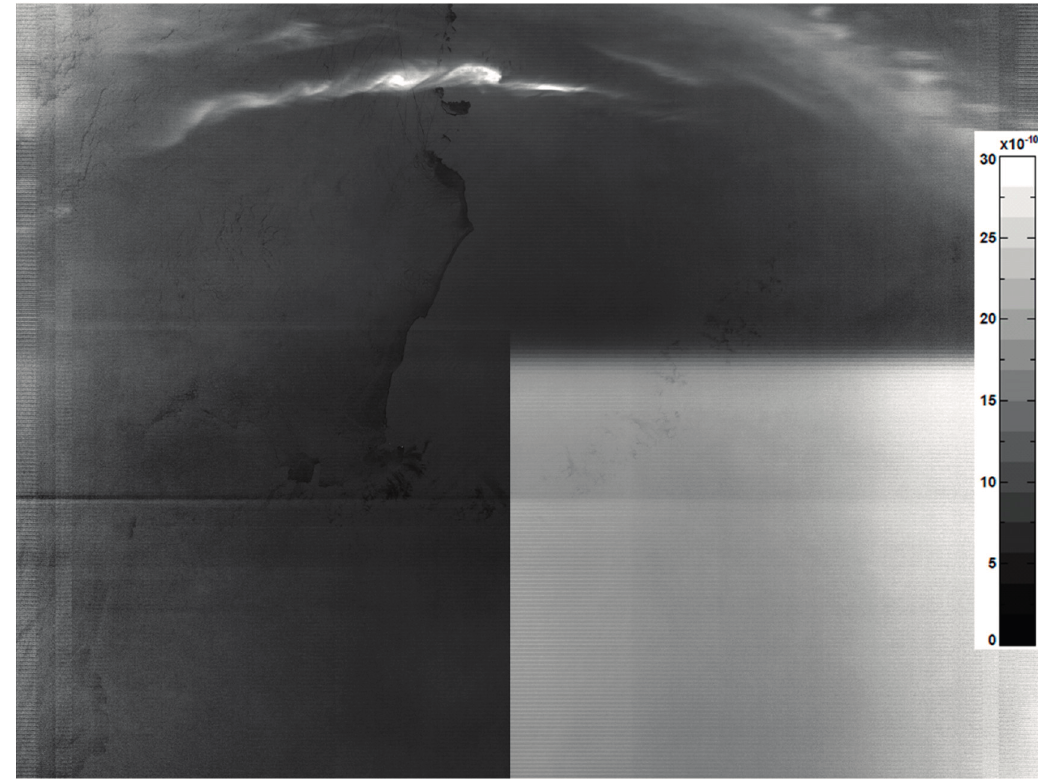
Figure 13. An example of Southern Hemisphere DNB SDR product before and after applying stray light correction. The image was taken on 19 June 2012, 08:01 UTC. The legend is in units of W·cm − 2 ·sr − 1